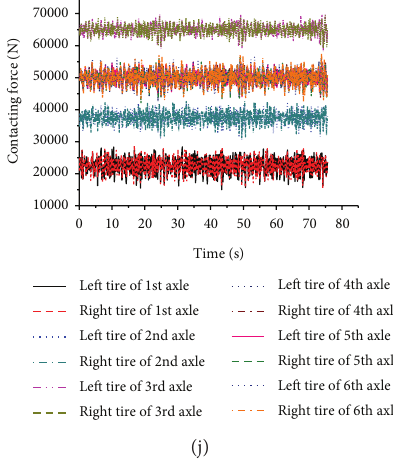
Figure 7: Time histories of responses using the vehicle-bridge coupling dynamic system: (a) vertical displacement of the bridge deck under the action of a 2-axle vehicle; (b) contacting force between the tires of a 2-axle vehicle and the bridge deck; (c) vertical displacement of the bridge deck under the action of a 3-axle vehicle; (d) contacting force between the tires of a 3-axle vehicle and the bridge deck; (e) vertical displacement of the bridge deck under the action of a 4-axle vehicle; (f) contacting force between the tires of a 4-axle vehicle and the bridge deck; (g) vertical displacement of the bridge deck under the action of a 5-axle vehicle; (h) contacting force between the tires of a 5-axle vehicle and the bridge deck; (i) vertical displacement of the bridge deck under the action of a 6-axle vehicle; (j) contacting force between the tires of a 6-axle vehicle and the bridge deck.